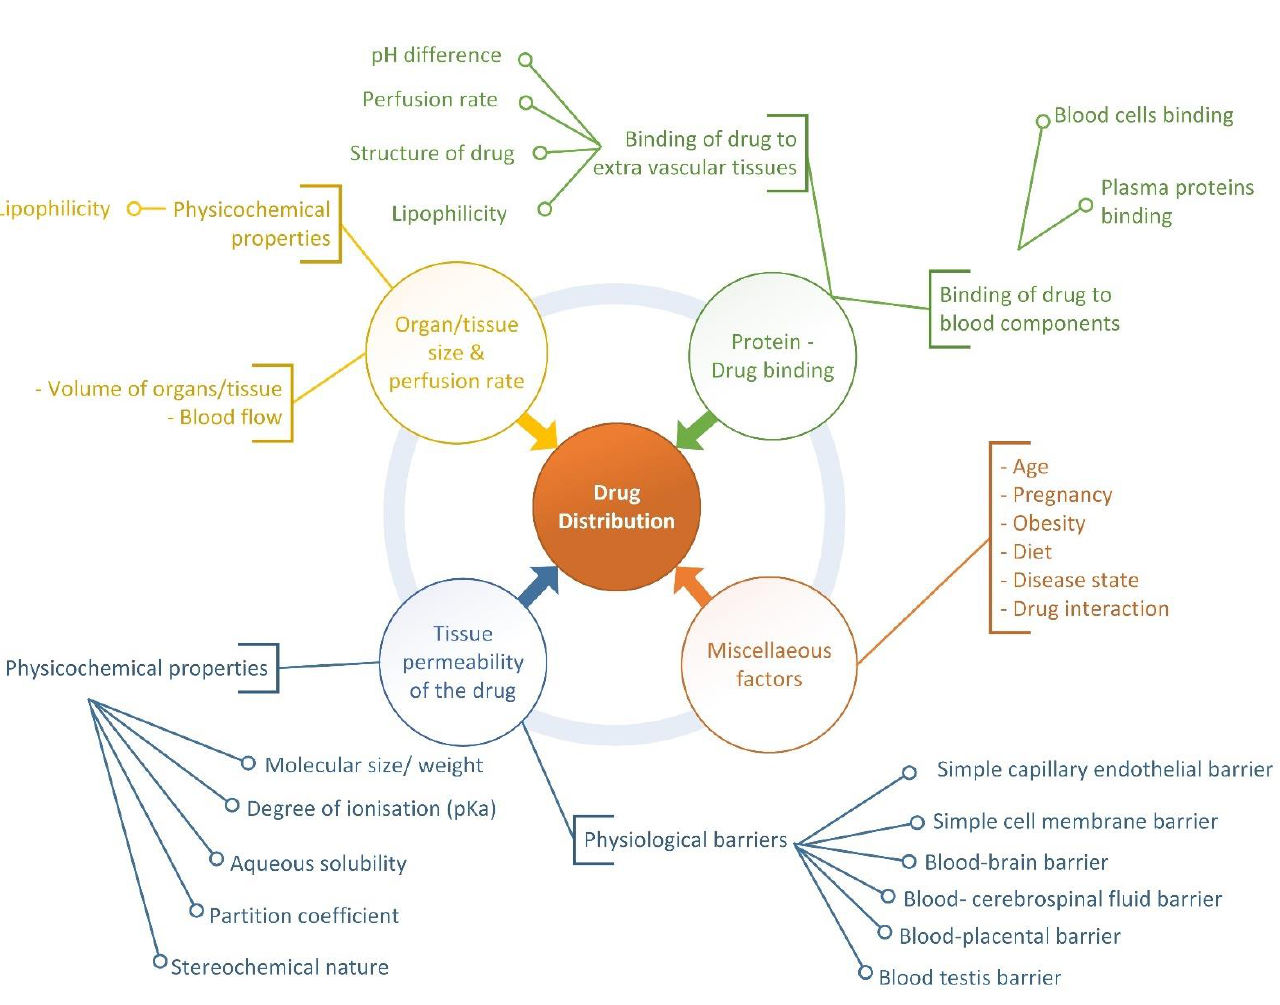
Figure 2. Factors influencing drug distribution.